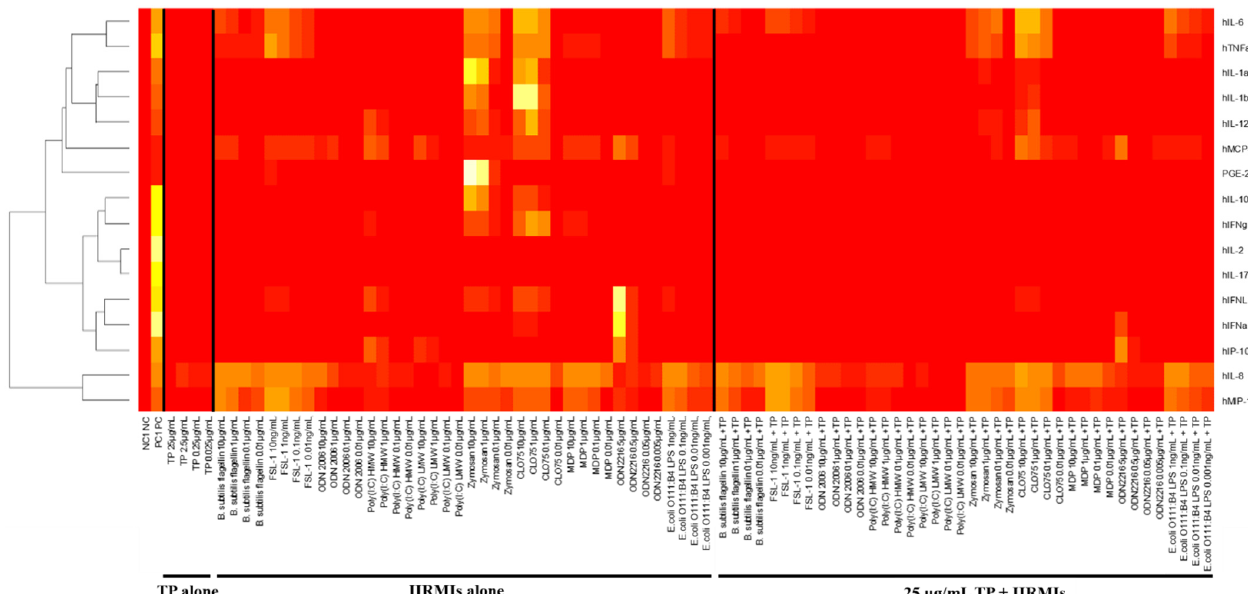
Figure 4. Innate Immune Response Modulating Impurity Treatment and Concentration Patterns via Euclidian Distance and Ward’s Clustering. PBMCs from 10 healthy human donors were treated with various concentrations of IIRMIs, alone and in combination with 25 μ g/mL Teriparatide (TP), compared to a PBS negative control (NC) and LPS/PHA-M/ODN positive control (PC), for 24 h. Supernatants were analyzed for the presence of cytokines by multiplex ELISA. Shown is the mean response of normalized values averaged across all donors, clustered based on cytokine response. Dendrograms were created using complete linkage clustering on the Euclidian distance matrices. Similar results for IIRMI clustering available in Figure S9.